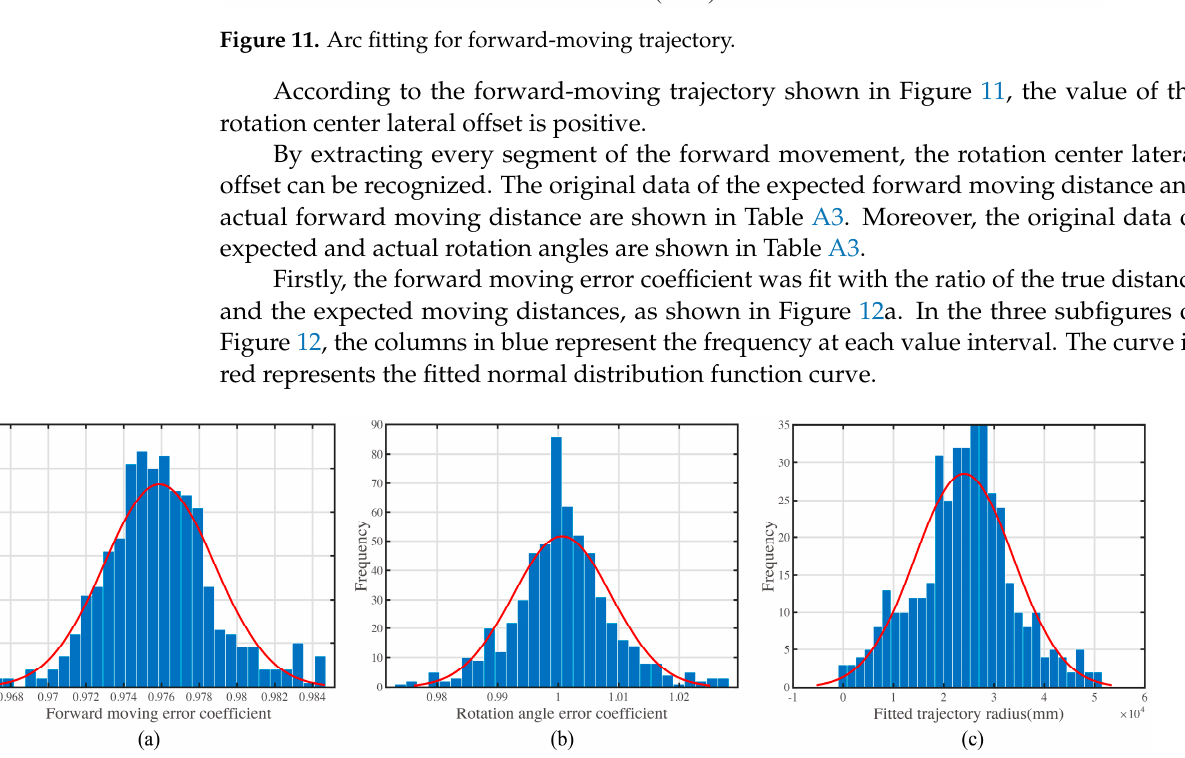
. Table 1. Error parameters estimated by the experiment. Error Parameters